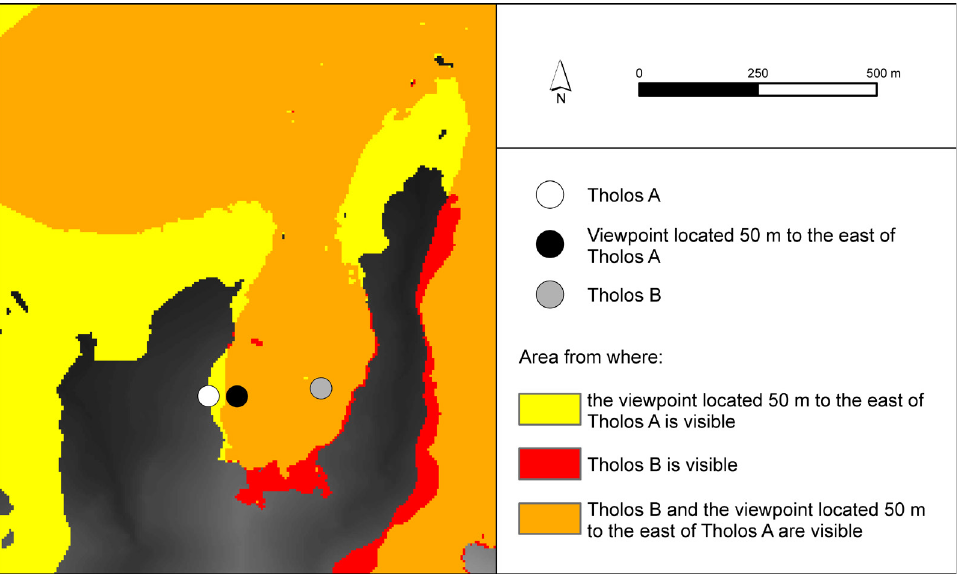
Figure 11. View of Tholos B (feature height: 5.1 m) and the viewpoint located 50 m to the east of Tholos A (feature height: 4.4 m). This map simulates the visual structure of the landscape if Tholos A had been built 50 m to the east, on the low ridge